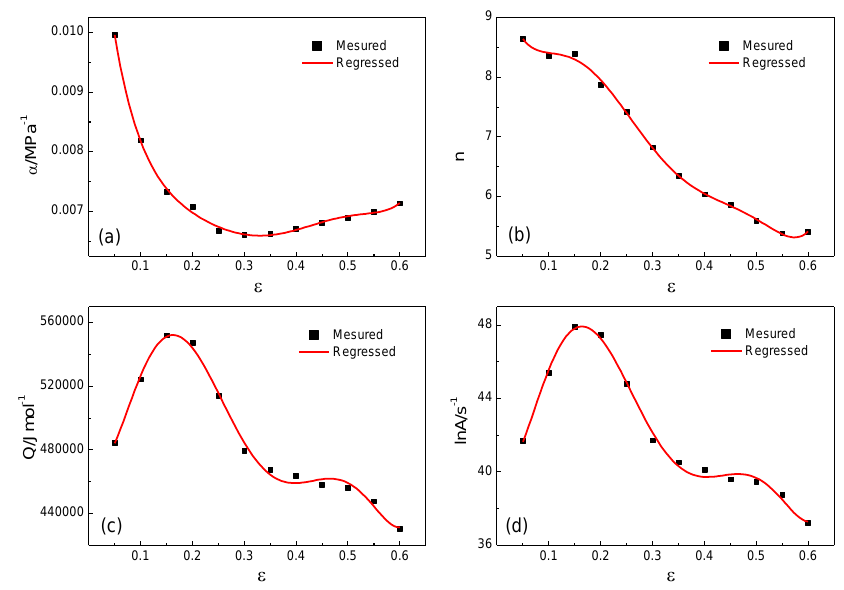
Figure 3. Relations between material parameters and ( a ) α; ( b ) n ; ( c ) Q ; ( d ) ln A .